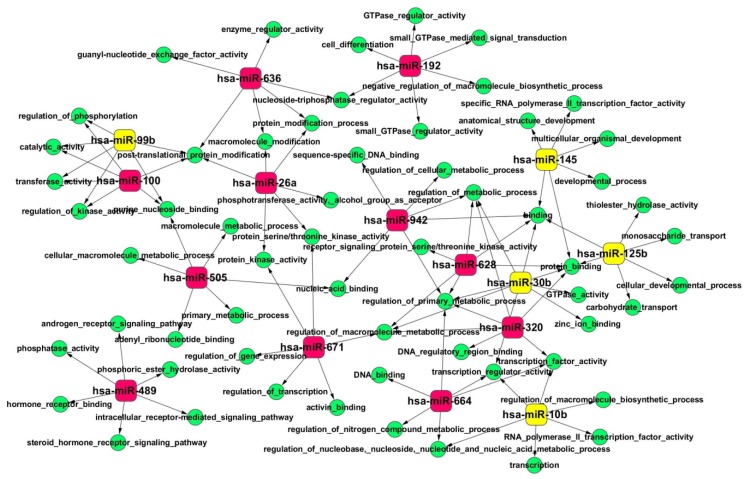
MicroRNA-GO-Network based on the interactions between miRNAs and their gene targets. Red nodes represent the top upregulated miRNAs and yellow nodes are top downregulated, whereas the green nodes are enriched GO terms.